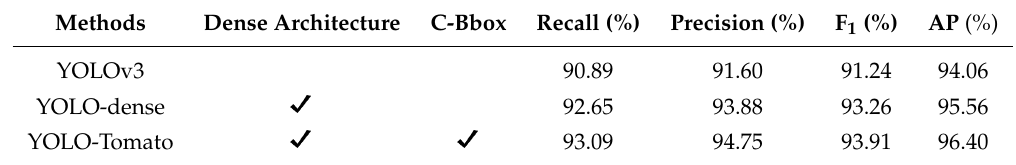
Table 1. Ablation study of dense architecture and circular bounding box.